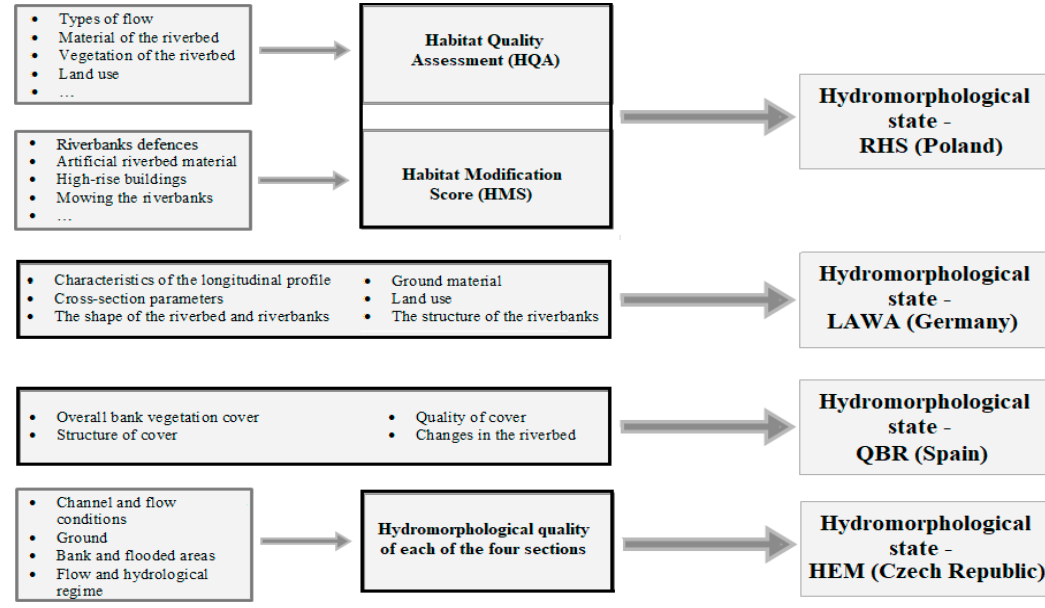
Figure 2. Diagram of the hydromorphological status analysis process for the described methods (own work).